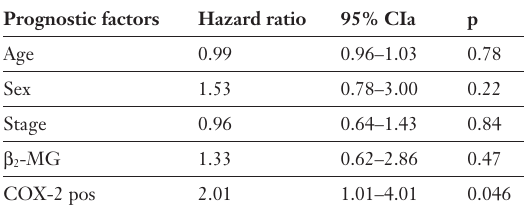
Prognostic factors for time to progression by univariate Cox regression.